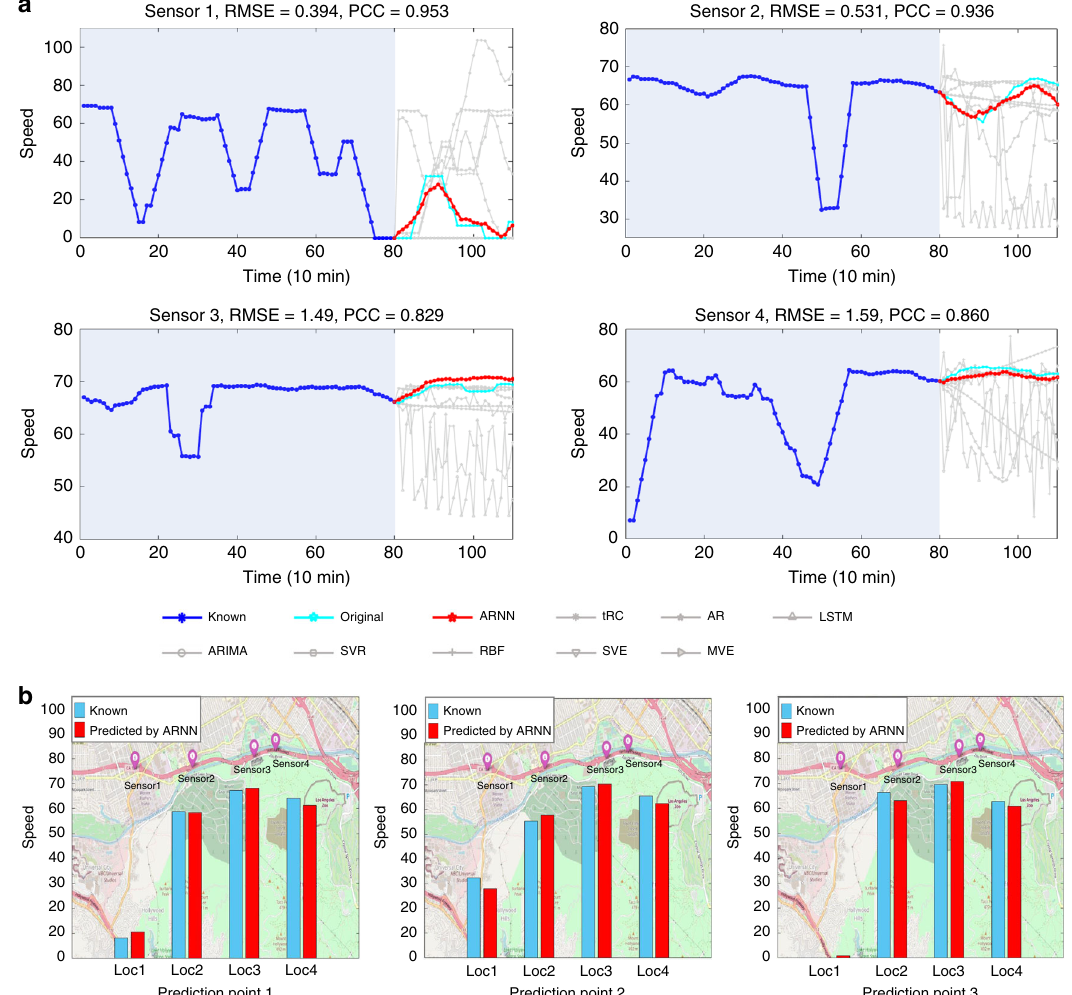
Fig. 6 The performance of ARNN prediction on a Los Angeles traf fi c dataset. a The traf fi c speeds of four nearby locations of Los Angeles (METR-LA) were predicted by ARNN and the other prediction methods. In each prediction, the inputs included the traf fi c speed (mile/h) from the former m = 80 time points, and the outputs were the speeds for L − 1 = 30 time points ahead. b The results predicted by ARNN for the four nearby locations (Loc1 to Loc4) are shown on the